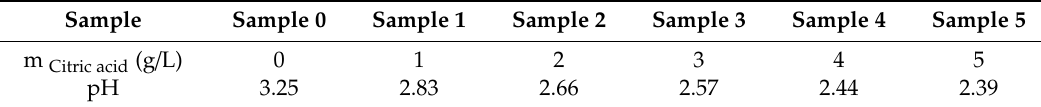
Table 1. pH of the aqueous solutions of the Carissa carandas extract stabilized by citric acid. Sample